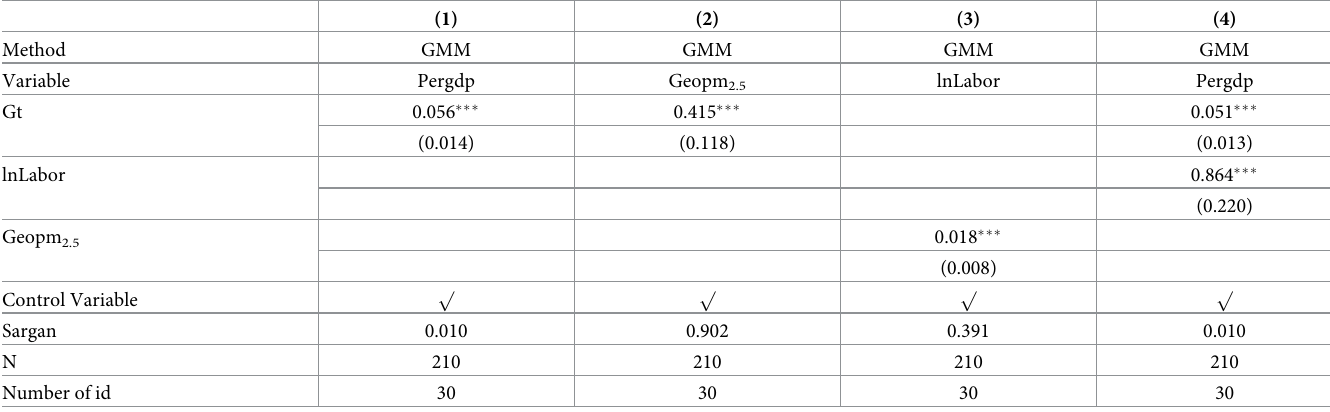
Table 6. Estimation of the mediating effect of labor supply at the national